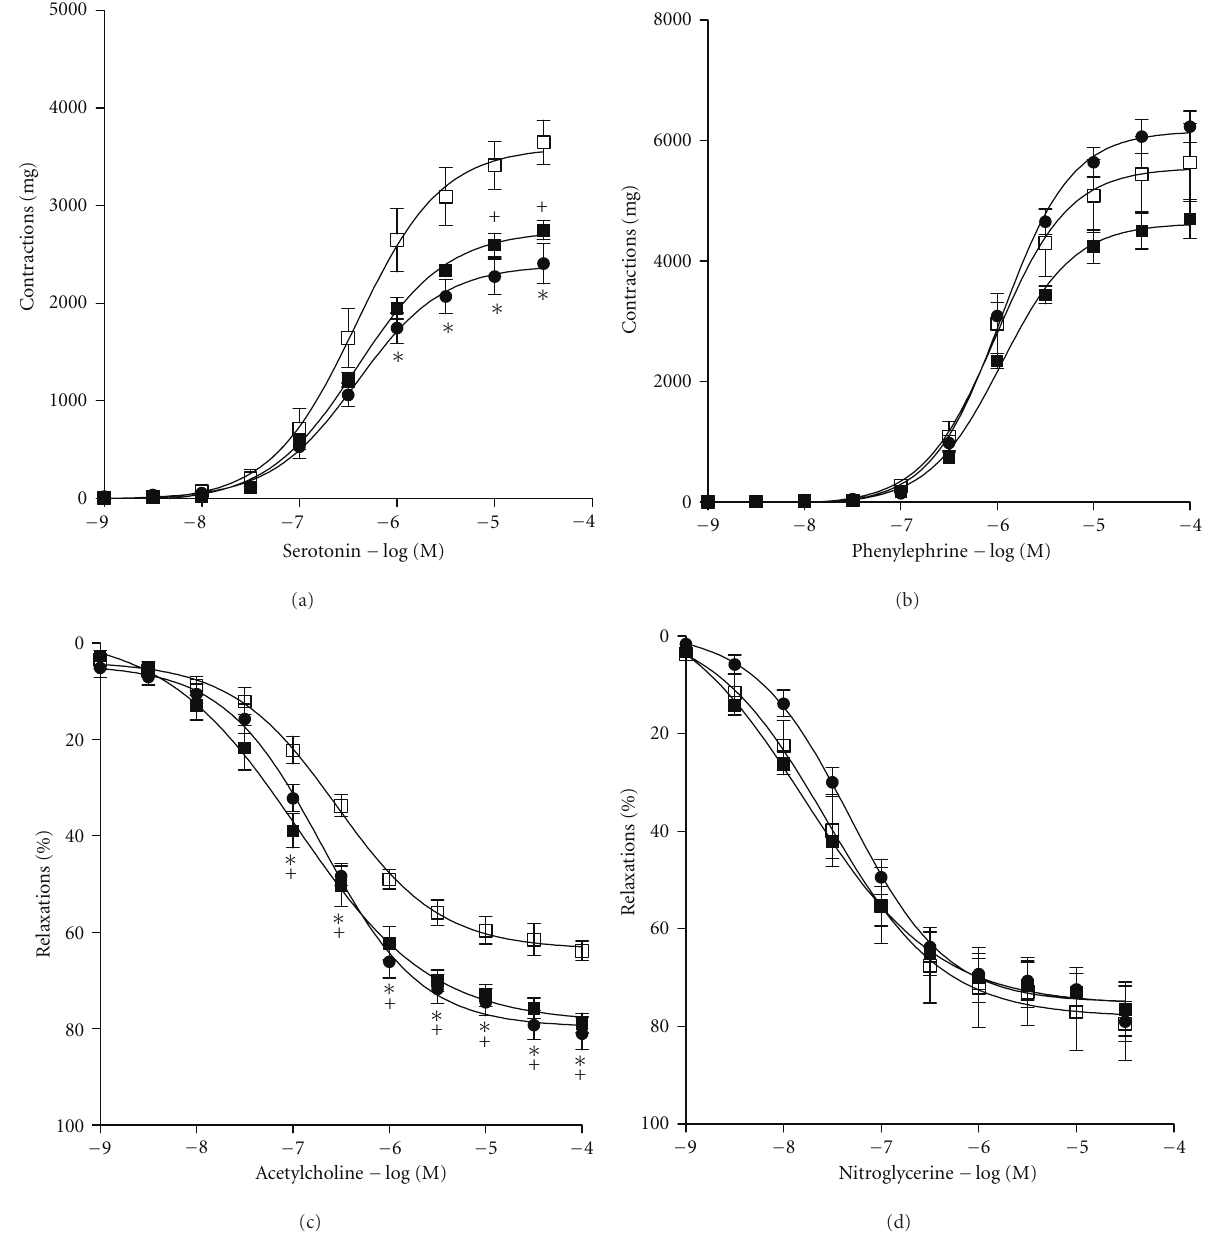
Figure 3: The e ff ect of cholesterol feeding and fluvastatin treatment on vascular contractions to serotonin (a) and phenylephrine (b) and relaxations to acetylcholine (c) and nitroglycerine (d) in isolated rabbit carotid artery. Rings of carotid arteries from control ( (cid:2) ) ( n = 5), cholesterol ( (cid:2) ) ( n = 5), and cholesterol + fluvastatin ( (cid:3) ) ( n = 5) groups. Values are expressed as means ± S.E.M. Cumulative dose-response curves for ACh and NTG precontracted with 10 − 6 M phenylephrine. P < 0 . 01 compared with control versus cholesterol ( ∗ ) and cholesterol versus cholesterol + fluvastatin ( + ) groups, ANOVA followed by Bonferroni post hoc test.